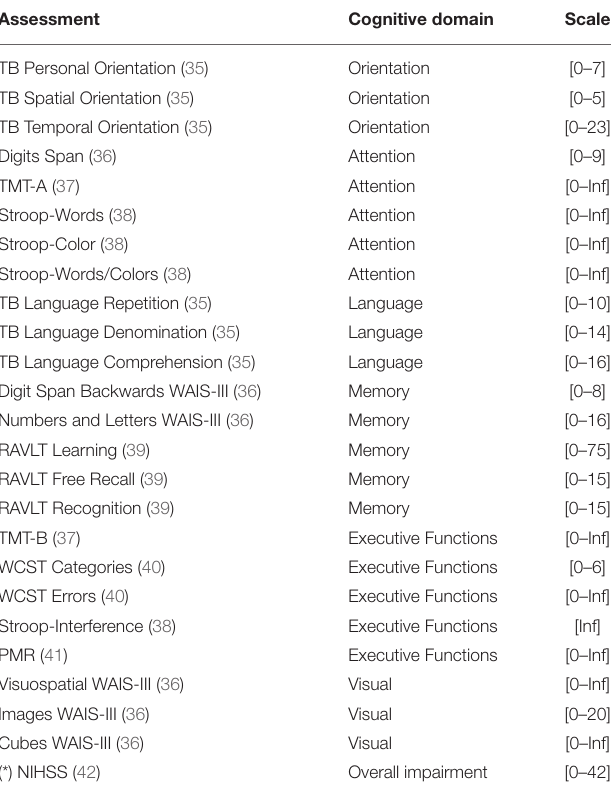
TABLE 1 | List of neuropsychological assessments administrated at the Guttmann Institut at admission and discharge.